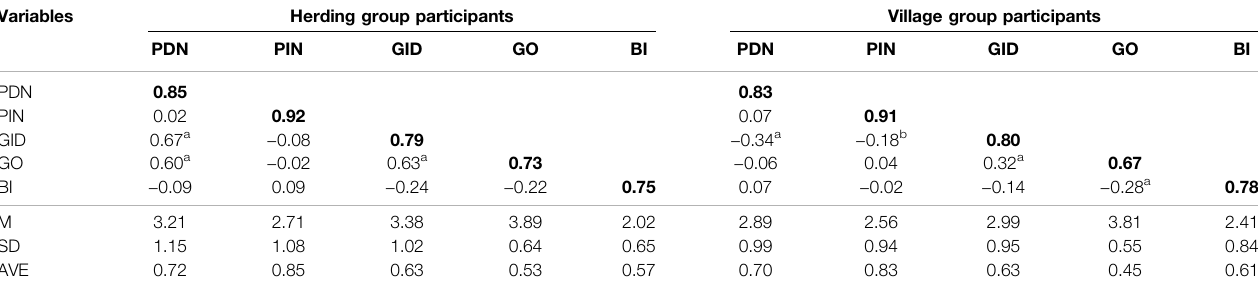
TABLE 2 | Zero-Order Correlations, Means, and Standard Deviations of Measured Variables for Both Herding Group and Village Group Participants. Variables Herding group participants Village group participants PDN